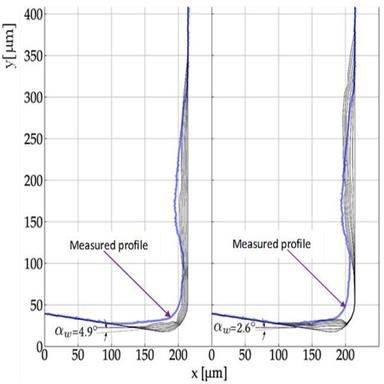
Simulated tool wear progression of the tungsten carbide tool in orthogonal machining of Ti6Al4V using hybrid SPH-FEM method for different cutting lengths .